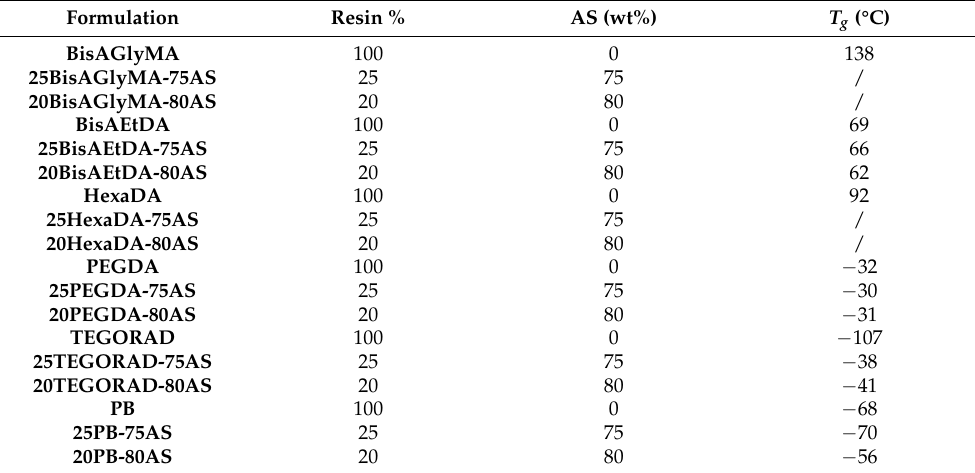
Table 3. Formulations composition and glass transition temperature ( T g ) of the obtained cross- linked